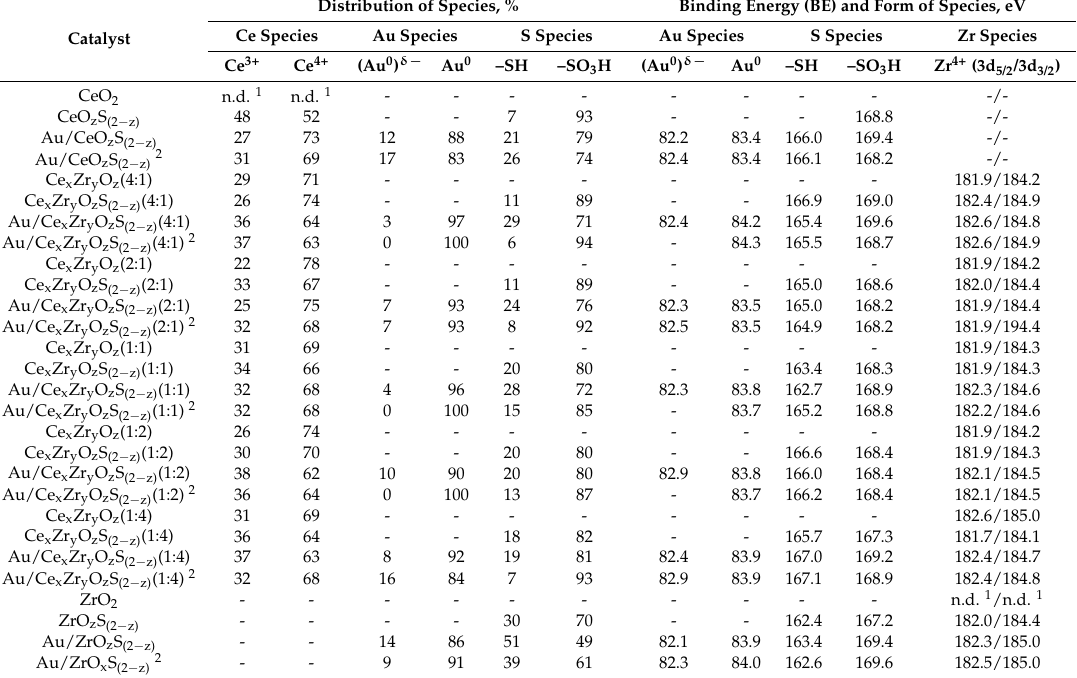
Table 5. Distribution of species from XPS study and the binding energy (BE) and the form of species on the external surface of